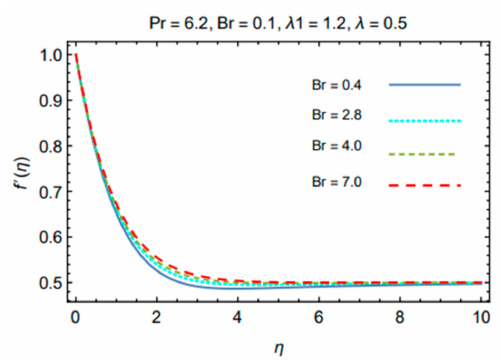
Figure 4. Variation in f (cid:48) ( η ) against Br .